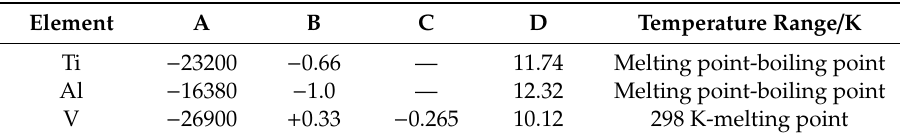
Table 5. Vapor pressure constant of main elements in Ti-6Al-4V alloy.